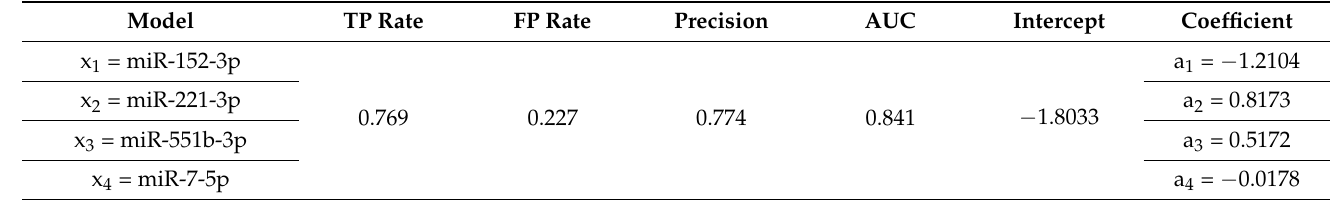
Table 4. Summary of the basic parameters and common quality measures of the